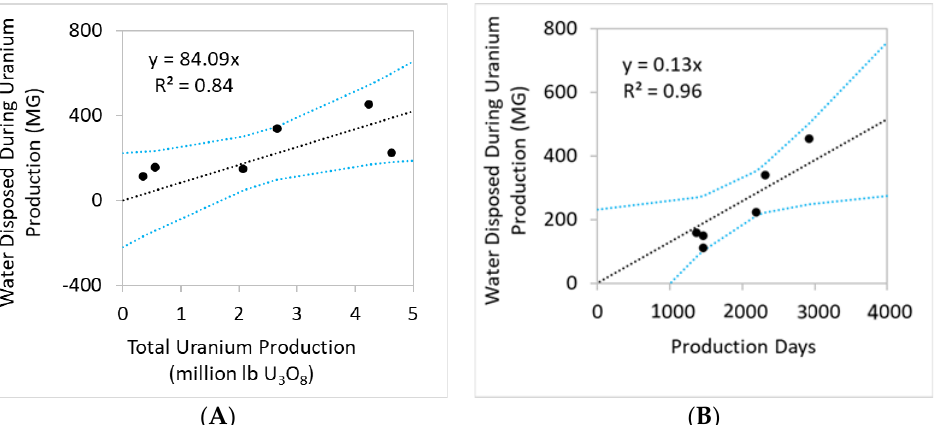
Figure 11. Water disposed during the uranium production phase as a function of ( A ) amount of uranium produced (as lb U 3 O 8 ) and ( B ) production days for all six ISR operations. Compiled data used to construct these graphs as well as associated references are publicly available online [18]. Note: MG = million gallons. Black line is the linear trend line and blue lines are the 95 percent confidence intervals.